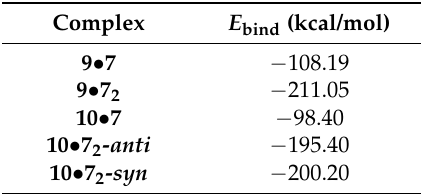
Table 6. Binding energies computed at the B97-D3/(cc-pVTZ+LANL2DZ) level for the host–guest supramolecular associates with stoichiometry 1:1 and 1:2 [90].